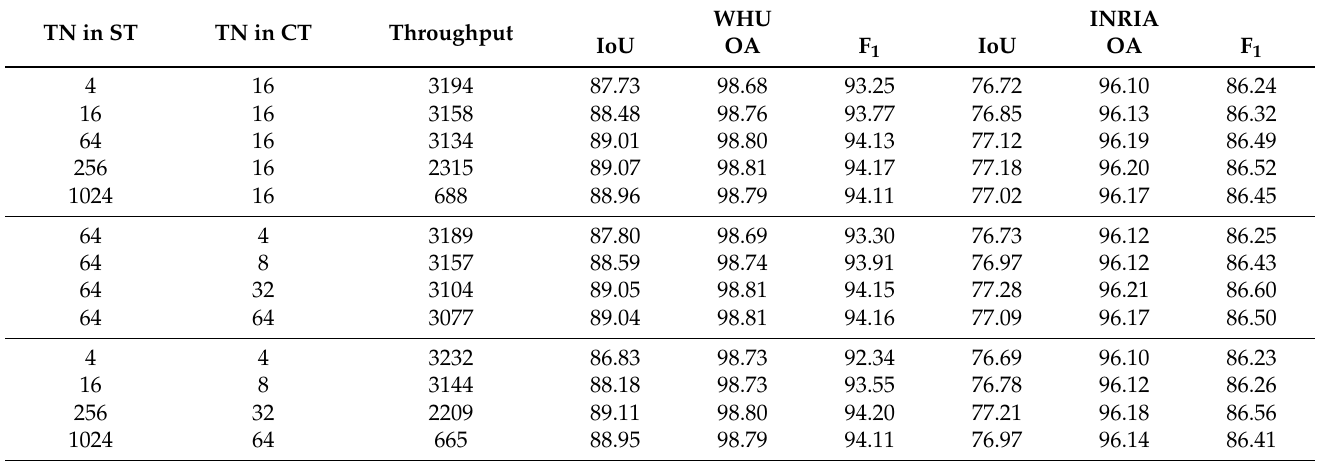
Table 5. Ablation study of our method SST ( R 18, S 4 ) on the sparse token number ( TN ) in the spatial and channel transformers. “Throughput” means the number of images (512 × 512 pixels) processed per second at the inference